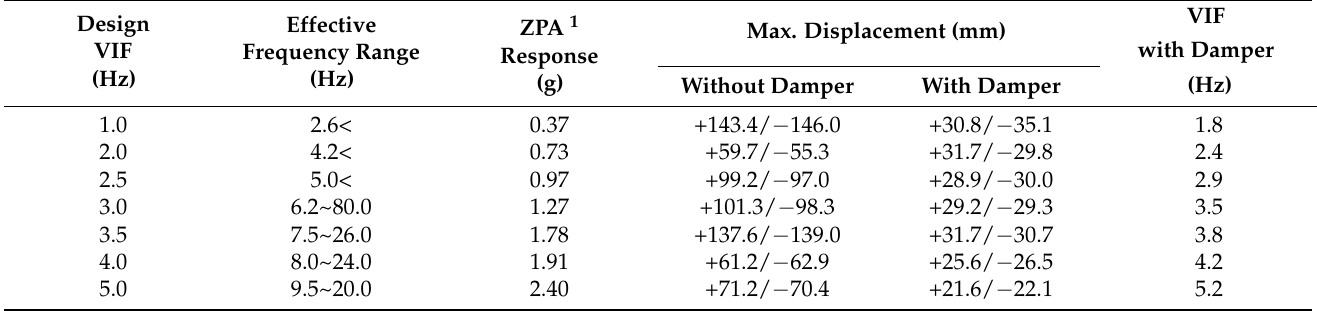
Table 4. Summary results of vertical seismic isolation performance with design